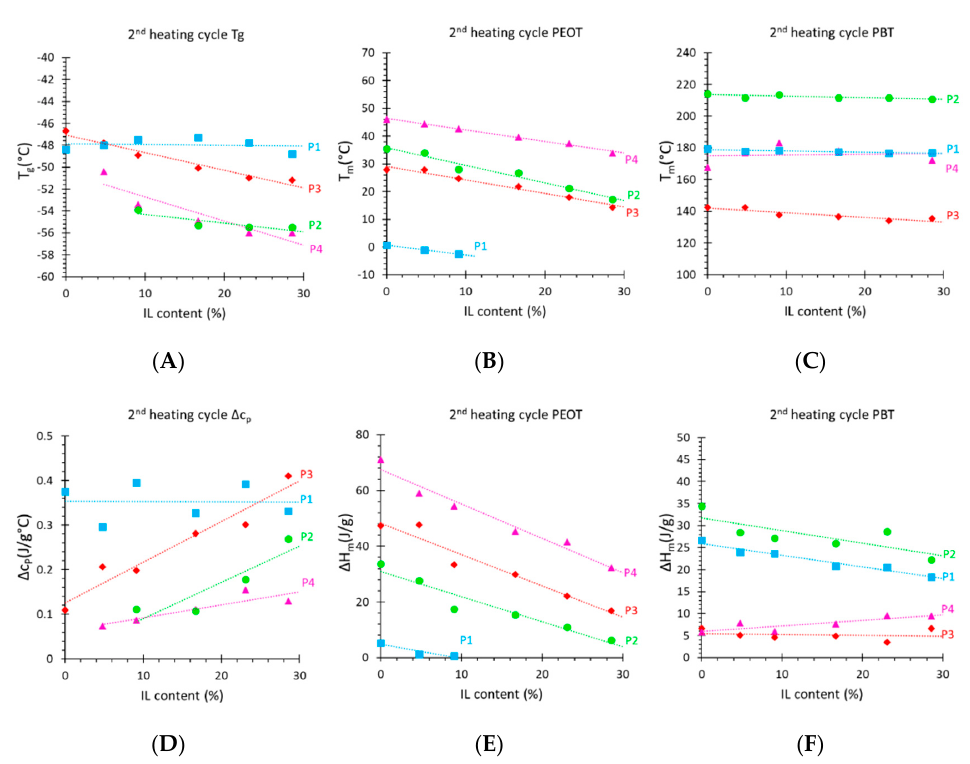
Figure 4. ( A ) Glass transition temperature, ( B ) poly(ethylene oxide terephthalate) (PEOT) phase melting temperature, and ( C ) polybutylene terephthalate (PBT) phase melting temperature. ( D ) Change in specific heat, and ( E ) melting enthalpy of the PEOT phase and ( F ) of the PBT